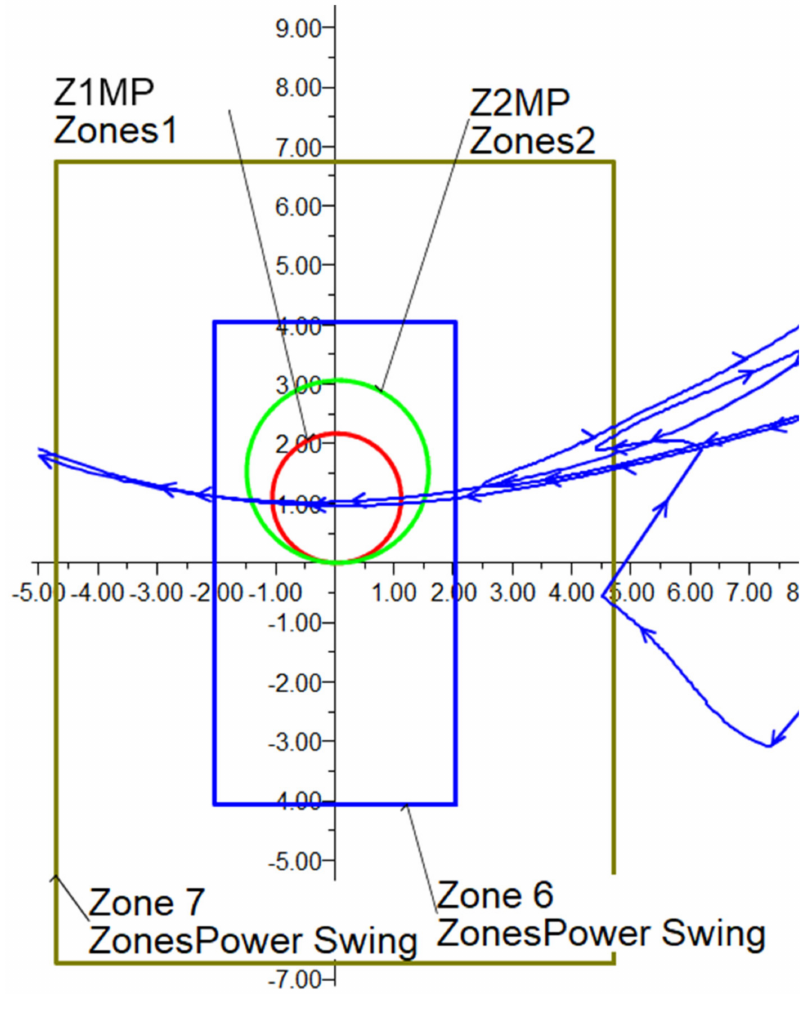
Figure 21. Test 2 : R-X plot with OOS relay on CCT-1